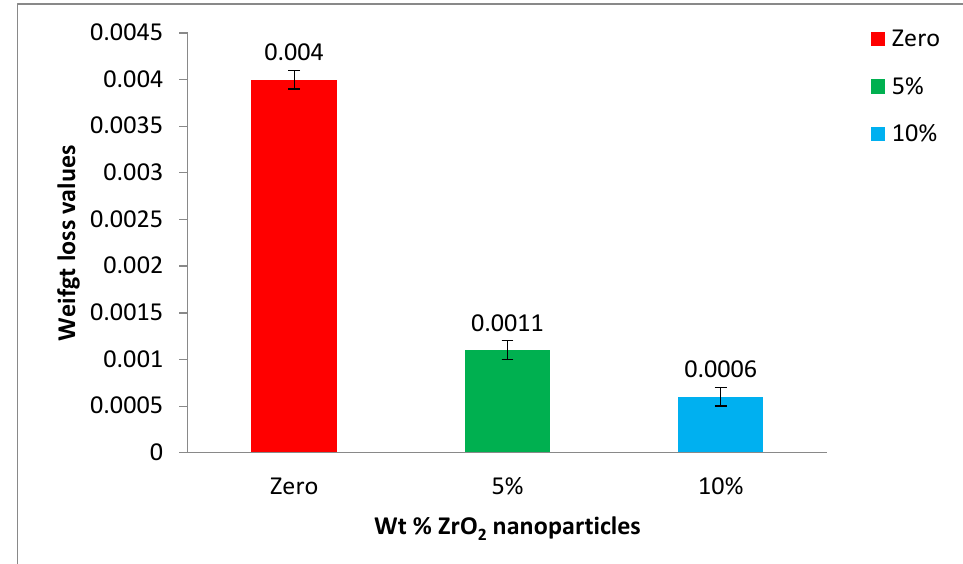
Figure 11. Mean weight loss of the tested groups after wear testing.